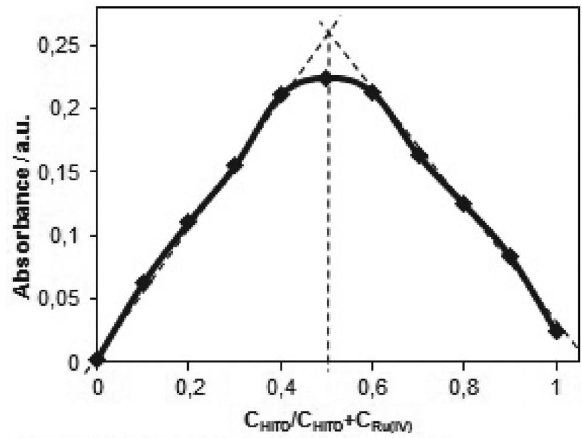
Fig 7. The method of continuous